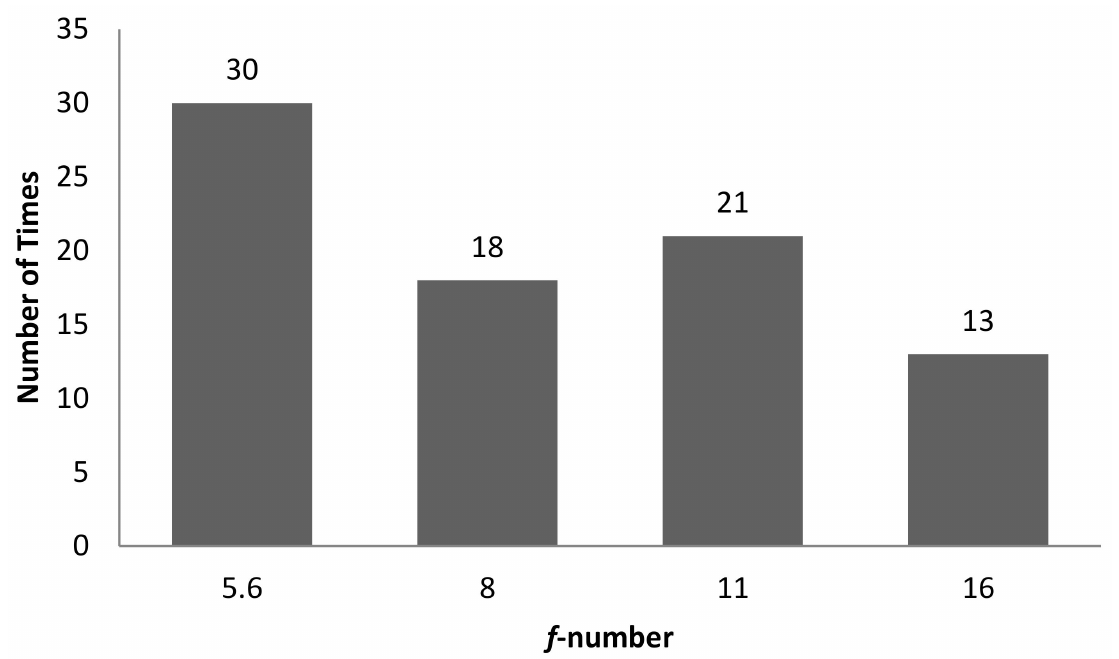
Figure 16. Bar chart showing the number of times correlation with R 2 ≥ 0.7 occurred for each f -number setting for an illumination angle of 60 ◦ for experimental setup